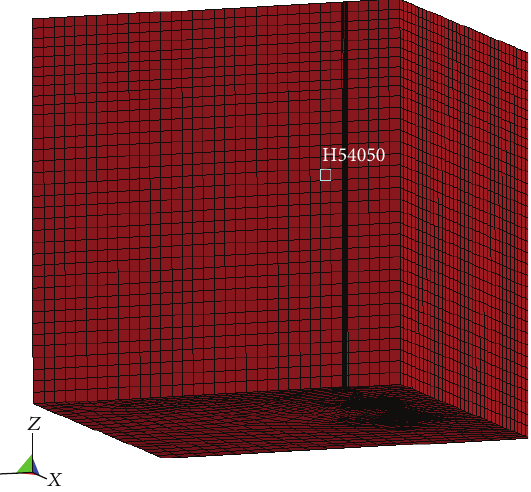
Figure 3: Monitoring element in the model with 6m charging length.